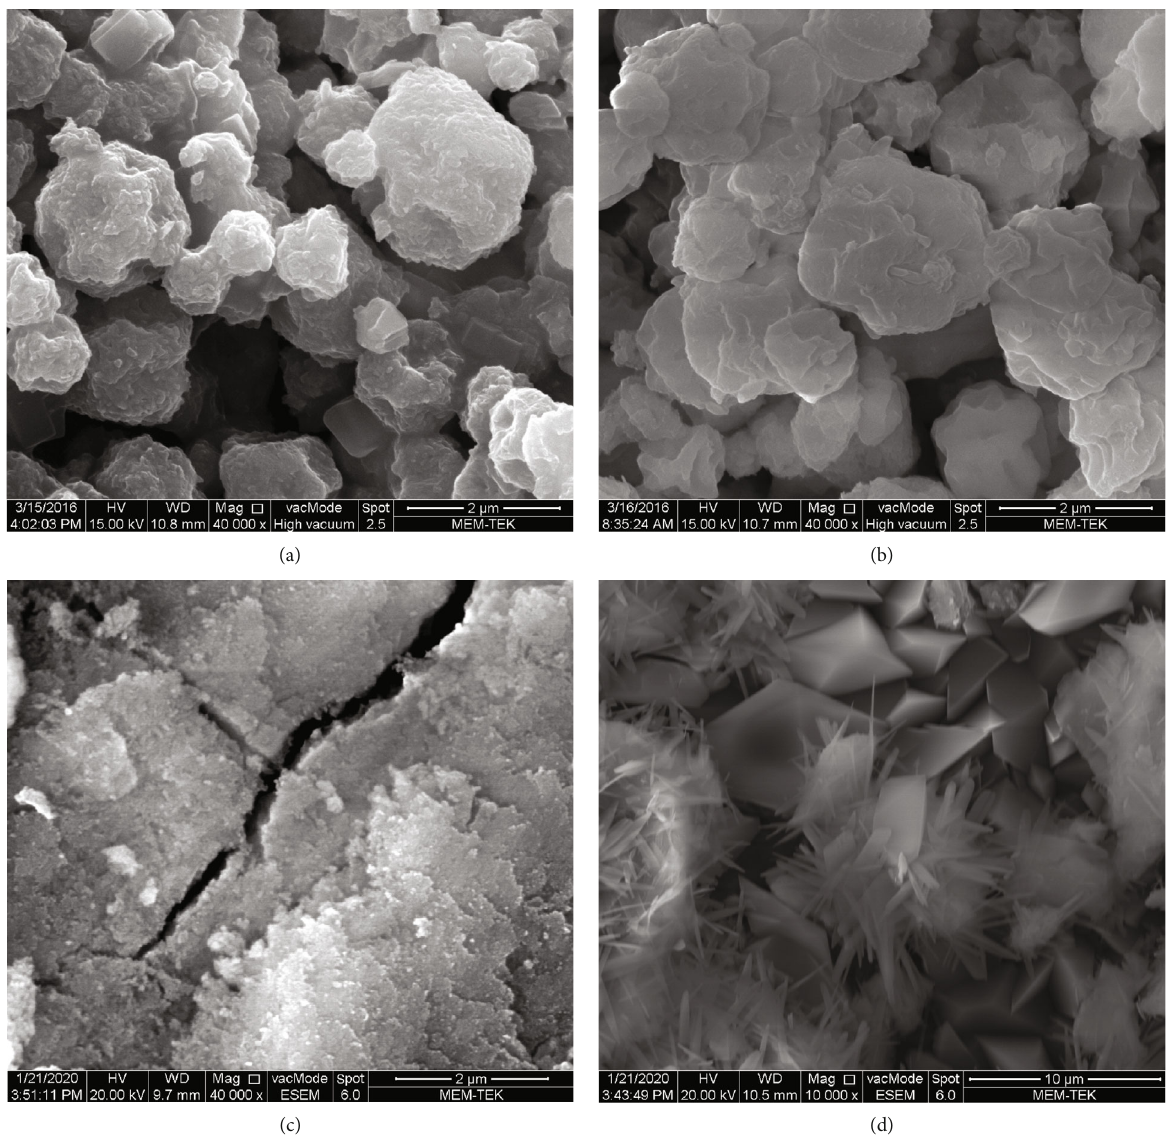
Figure 5: SEM images of (a) HAp-GEL-5-FU 2% GA, (b) HAp-GEL-5-FU 5% GA, (c) HAp-GEL 2% GA, and (d) HAp-GEL 5%